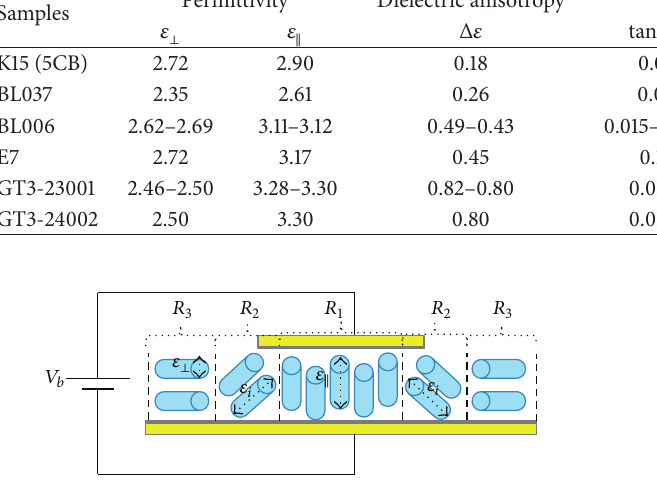
Figure 4: Liquid crystal cell regions for 𝑉 𝑏 = 𝑉 max , with region 𝑅 1 in the center, simulated as the parallel state, region intermediate state, and region 𝑅 3 on both sides simulated as the perpendicular state.